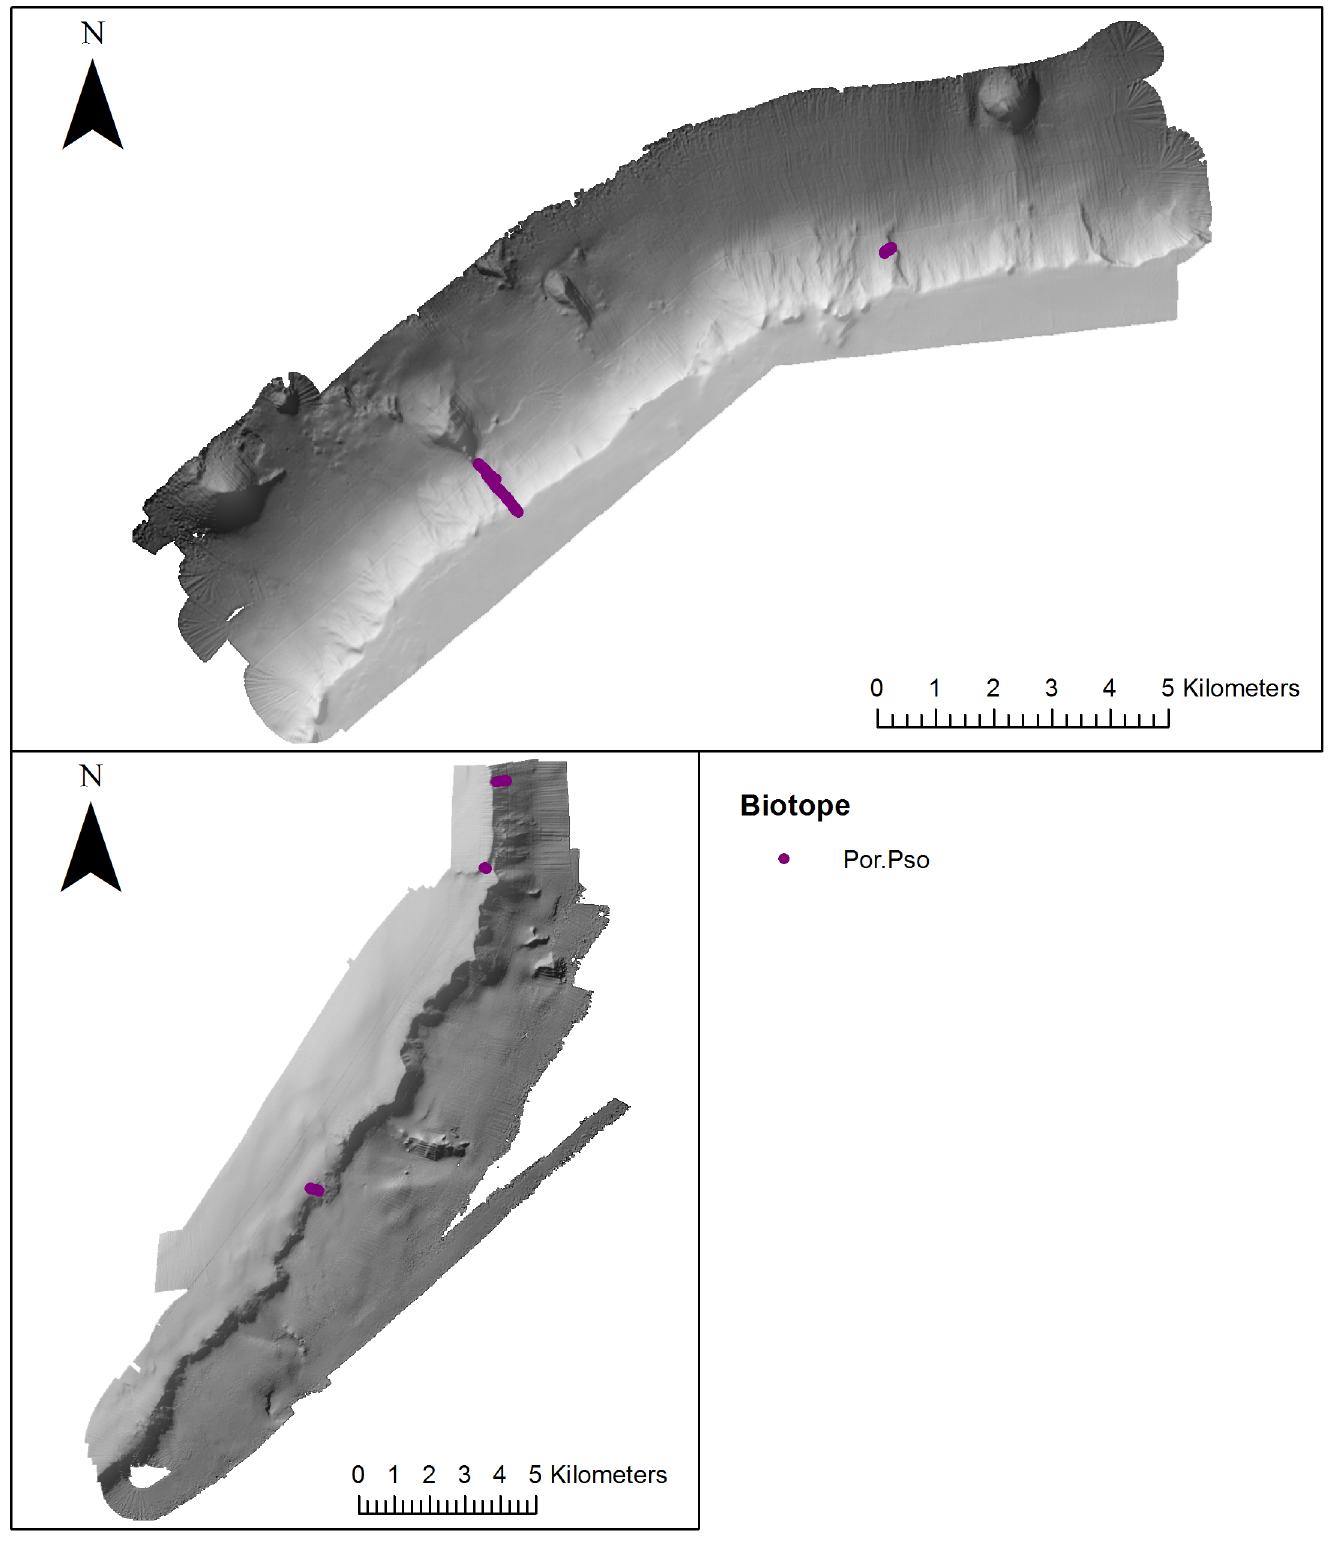
Fig 9. Distribution of sponge dominated communities (mapped using video footage) biotope on the NW and SE side of Anton Dohrn Seamount. Refer to Fig 2 for bathymetric scale.